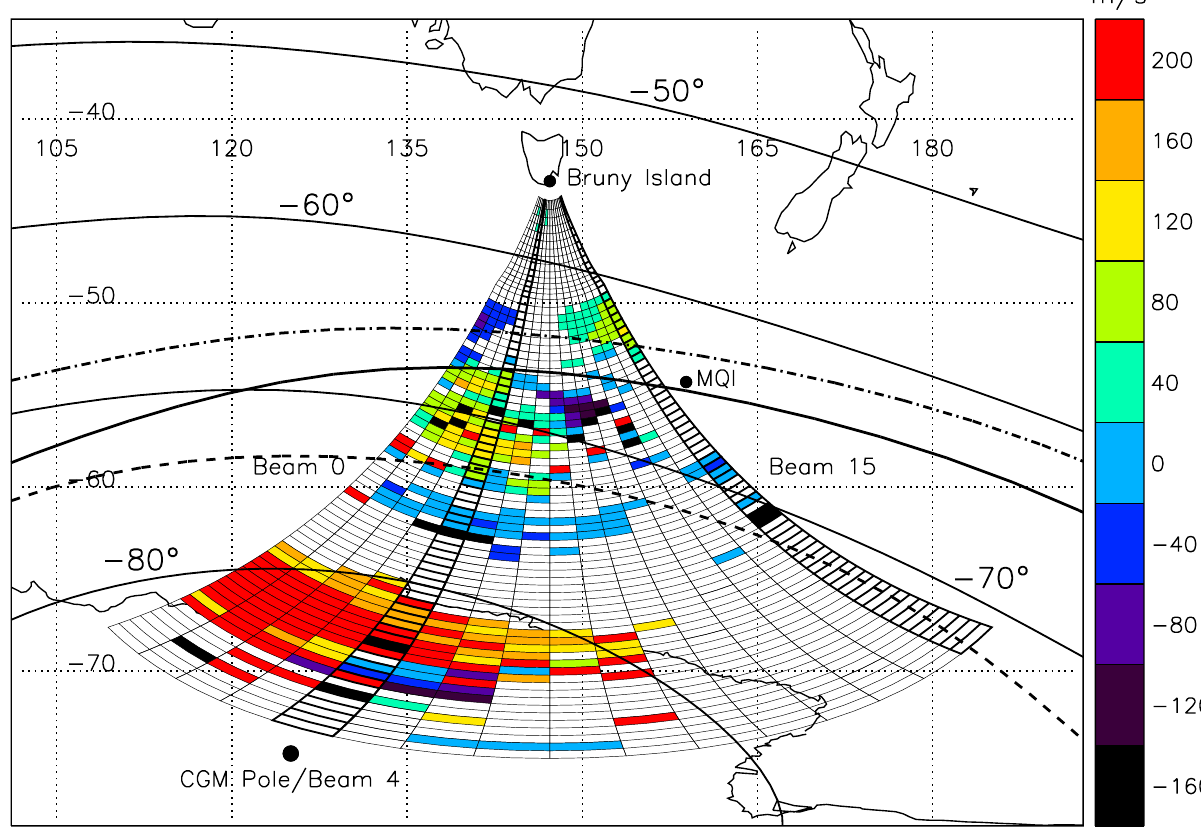
Fig. 1. Field of view (FOV) of the TIGER radar mapped to cylindrical geographic coordinates with AACGM latitudes − 50 ◦ , − 60 ◦ , − 70 ◦ , and − 80 ◦ 3 superimposed. Beam 4, which points toward the CGM pole, and beam 15, which becomes a magnetic zonal beam at the furthest ranges, are shown in bold. LOS Doppler velocities recorded during the full scan commencing at 12:34UT on 27 February 2000 are also shown. The colour key means that all velocities in the range 140 < v LOS ≤ 180ms − 1 are coloured orange. Auroral oval boundaries given by the Starkov (1994) model for AL = − 150nT and Macquarie Island (MQI) located at 22:00MLT have been superimposed: poleward boundary of discrete aurora (dashed curve), the equatorward boundary of discrete aurora (solid curve), and the equatorward boundary of diffuse aurora (dashed-dotted